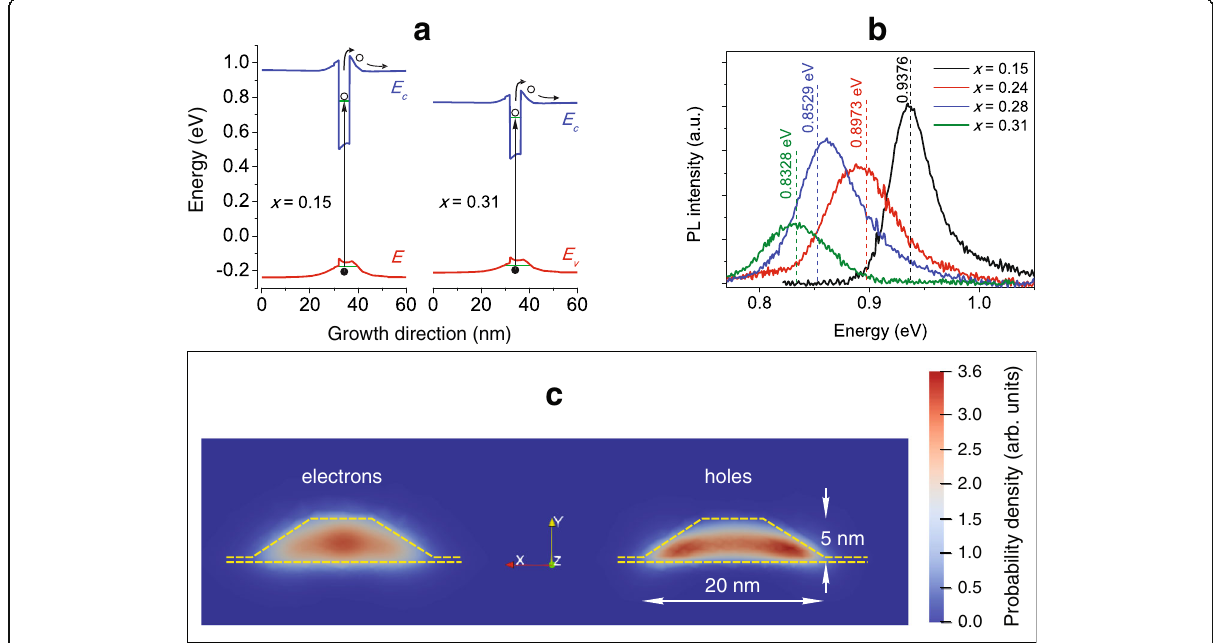
Fig. 4 Color online. Modeling calculations for the metamorphic InAs/In x Ga 1 − x As QD structures: a band profiles in the structures with different x along the growth axis; b the real QD PL bands and their calculated peak positions (dashed verticals); and c probability densities of the confined electrons and holes for the InAs/In 0.15 Ga 0.85 As QD. All the calculations of modeled structures were carried out for 300